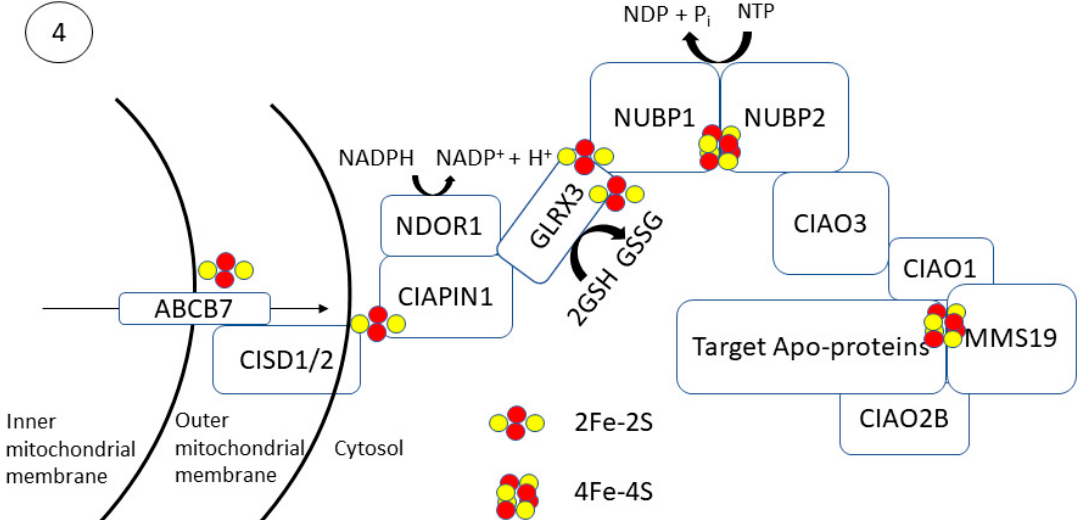
Figure 4. Formation and trafficking of [4Fe-4S] clusters to extramitochondrial target proteins occur via the cytosolic iron–sulfur assembly (CIA) pathway. The transmembrane protein, ABCB7, transfers the appropriate Fe and S for de novo extramitochondrial cluster synthesis, thought to be in the form of a glutathione-coordinated [2Fe-2S] cluster ([2Fe-2S](SG) 4 ). On the outer mitochondrial membrane, CISD1/2 are thought to be able to transfer a reduced [2Fe-2S] cluster to the CIAPIN-NDOR1 complex, facilitated by GLRX3. This [2Fe-2S] cluster may be transferred for de novo [4Fe-4S] synthesis on the NUBP1/2 scaffolding complex facilitated by CIAO3. The [4Fe-4S] cluster is transferred to the CIAO1–CIAO2B–MMS19 complex, where MMS19 can directly interact with cytosolic and nuclear target apo ‐ proteins for cluster insertion.